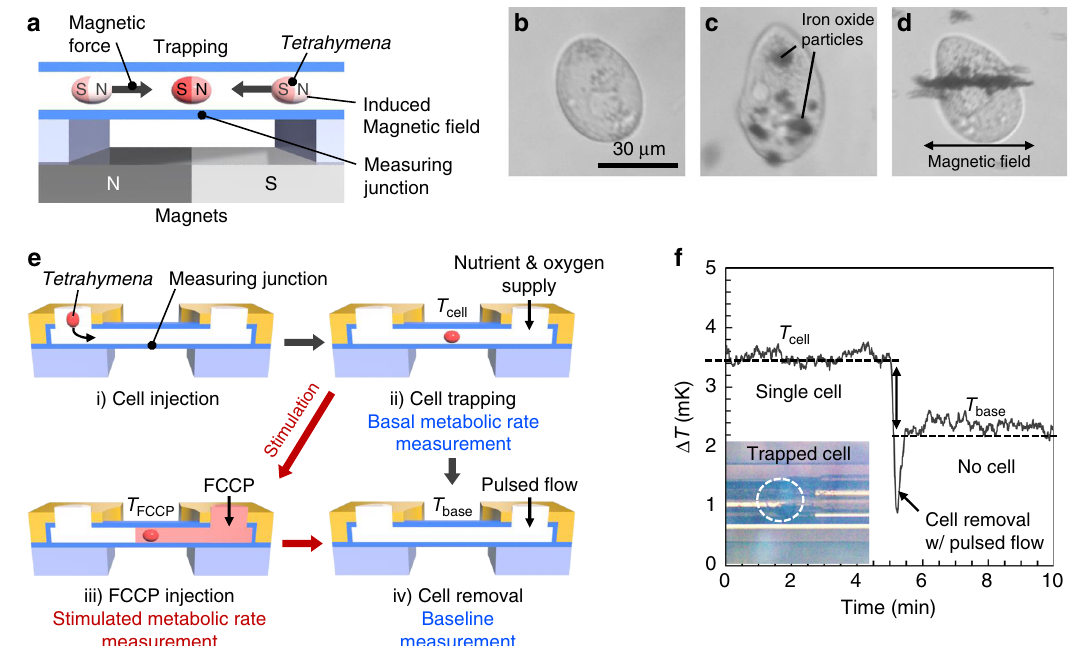
Fig. 3 Magnetic cell trapping and single-cell measurement procedure. a Illustration of magnetic cell trapping. The external magnetic fi eld generated by two magnets trapped a single cell, which is internalized with iron oxide nanoparticles at the interface of the magnets, where the highest magnetic fi eld occurred. b Tetrahymena before internalizing iron oxide nanoparticles. c Tetrahymena after internalizing iron oxide nanoparticles. d Tetrahymena with the iron oxide nanoparticles under external magnetic fi eld. More than fi ve ( n > 5) similar images of cells with nanoparticles were taken. e Procedure of single-cell metabolic rate measurement: (i) injection of a single Tetrahymena through the micro fl uidic channel, (ii) trapping of the cell in the middle of the suspended tube by the magnetic fi eld and measurement of the temperature with the cell ( T cell ), (iii) FCCP injection through the micro fl uidic channel to stimulate cell metabolism and measurement of the temperature with the stimulation ( T FCCP ), and (iv) cell removal with a pulse fl ow to measure baseline temperature ( T base ). f Representative result of the temperature signal during the single-cell measurement. Solid line represents the raw data of the temperature signal. Dashed lines represent the average values before and after cell removal ( T cell and T base , respectively) The inset photograph shows the Tetrahymena trapped by the magnetic fi eld during the measurement. Source data for 3f are provided as a Source Data fi